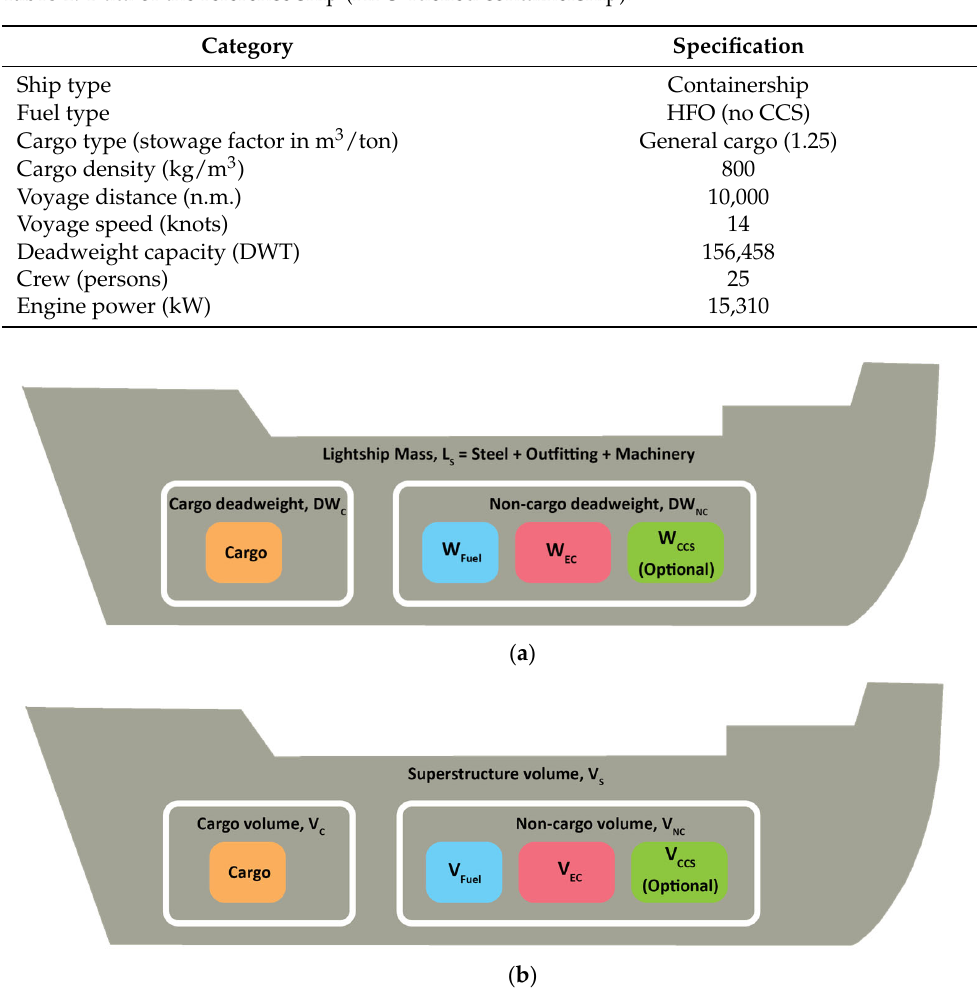
Figure 1. Research process flow diagram. Table 1. Data of the reference ship (HFO ‐ fuelled containership). Table 1. Data of the reference ship (HFO-fuelled containership).